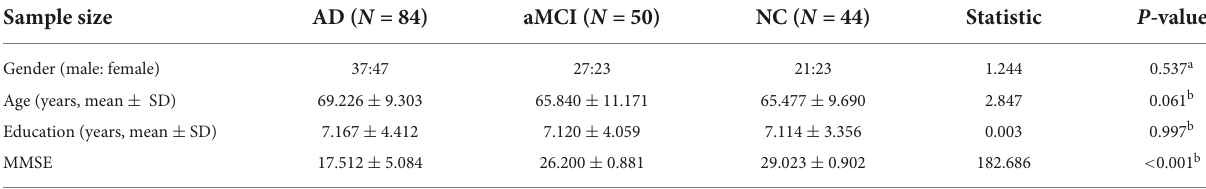
TABLE 1 Demographic data and clinical characteristics of the participants.